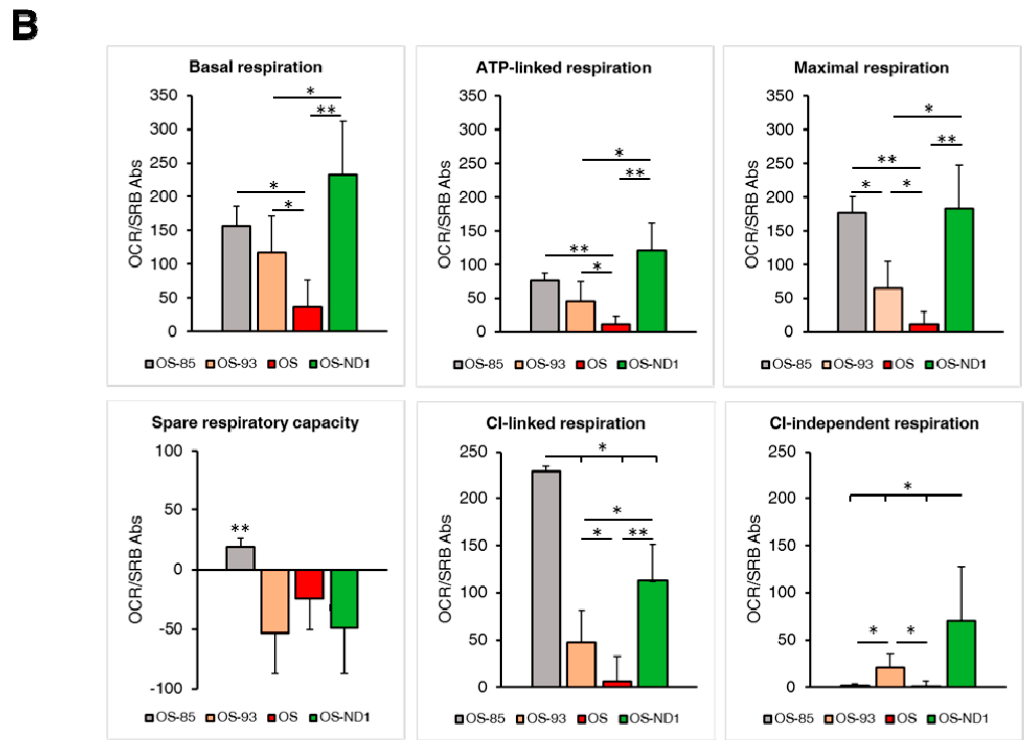
Figure 4. Mitochondrial respiration depends on ND1 abundance. ( A ) Oxygen consumption rate (OCR) profiles performed in 10 mM glucose medium upon injection of 1 µM oligomycin (Oligo), variable concentration of carbonyl cyanide 4-(trifluoromethoxy)phenylhydrazone (FCCP) determined by titration, 1 µM rotenone (Rote), and 1 µM antimycin A (Aa). Data (mean ± SD, n ≥ 4) are expressed as OCR (picomoles of O 2 per minute) normalized on SRB absorbance. All the data points from CC are statistically significant compared to all the other cell lines ( B ) Basal, ATP-linked and maximal respiration, spare respiratory capacity, rotenone sensitive, and insensitive OCR of mutant cells with different amount of ND1. Data (mean ± SD, n ≥ 4, * p -value < 0.05; ** p -value < 0.001) are expressed as OCR (picomoles of O 2 per minute) normalized on SRB absorbance.